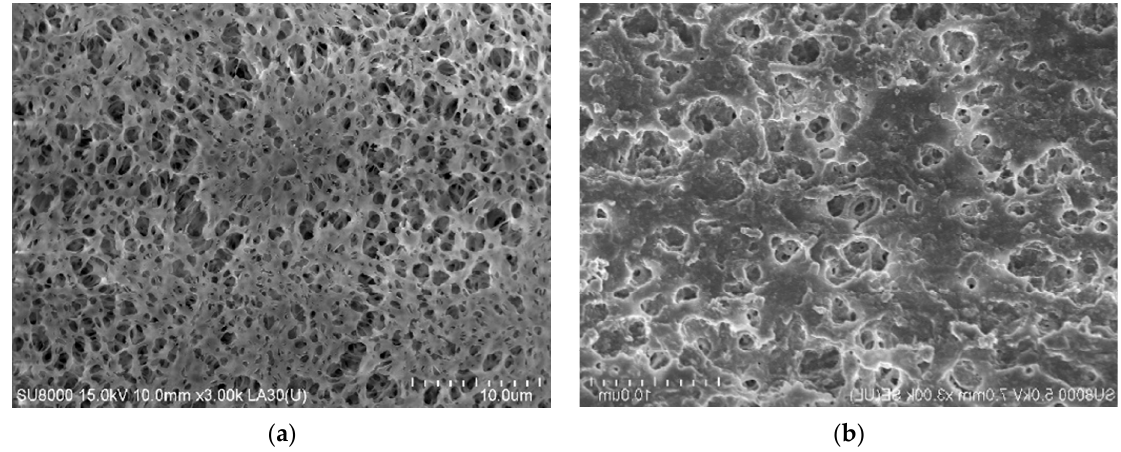
Figure 23. SEM images of Accurel PP S6/2 membrane: ( a ) internal surface of new membrane; ( b ) internal surface with deposit.